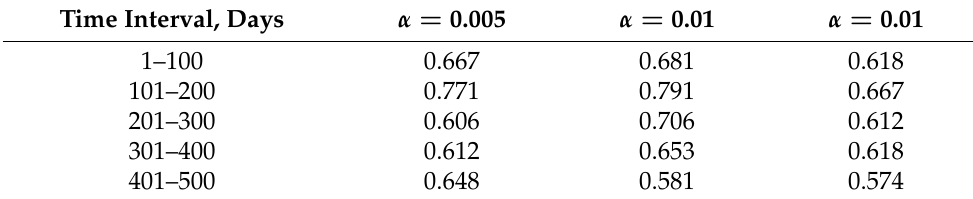
Table 3. Positive outcome frequency: opening by smoothed curve.